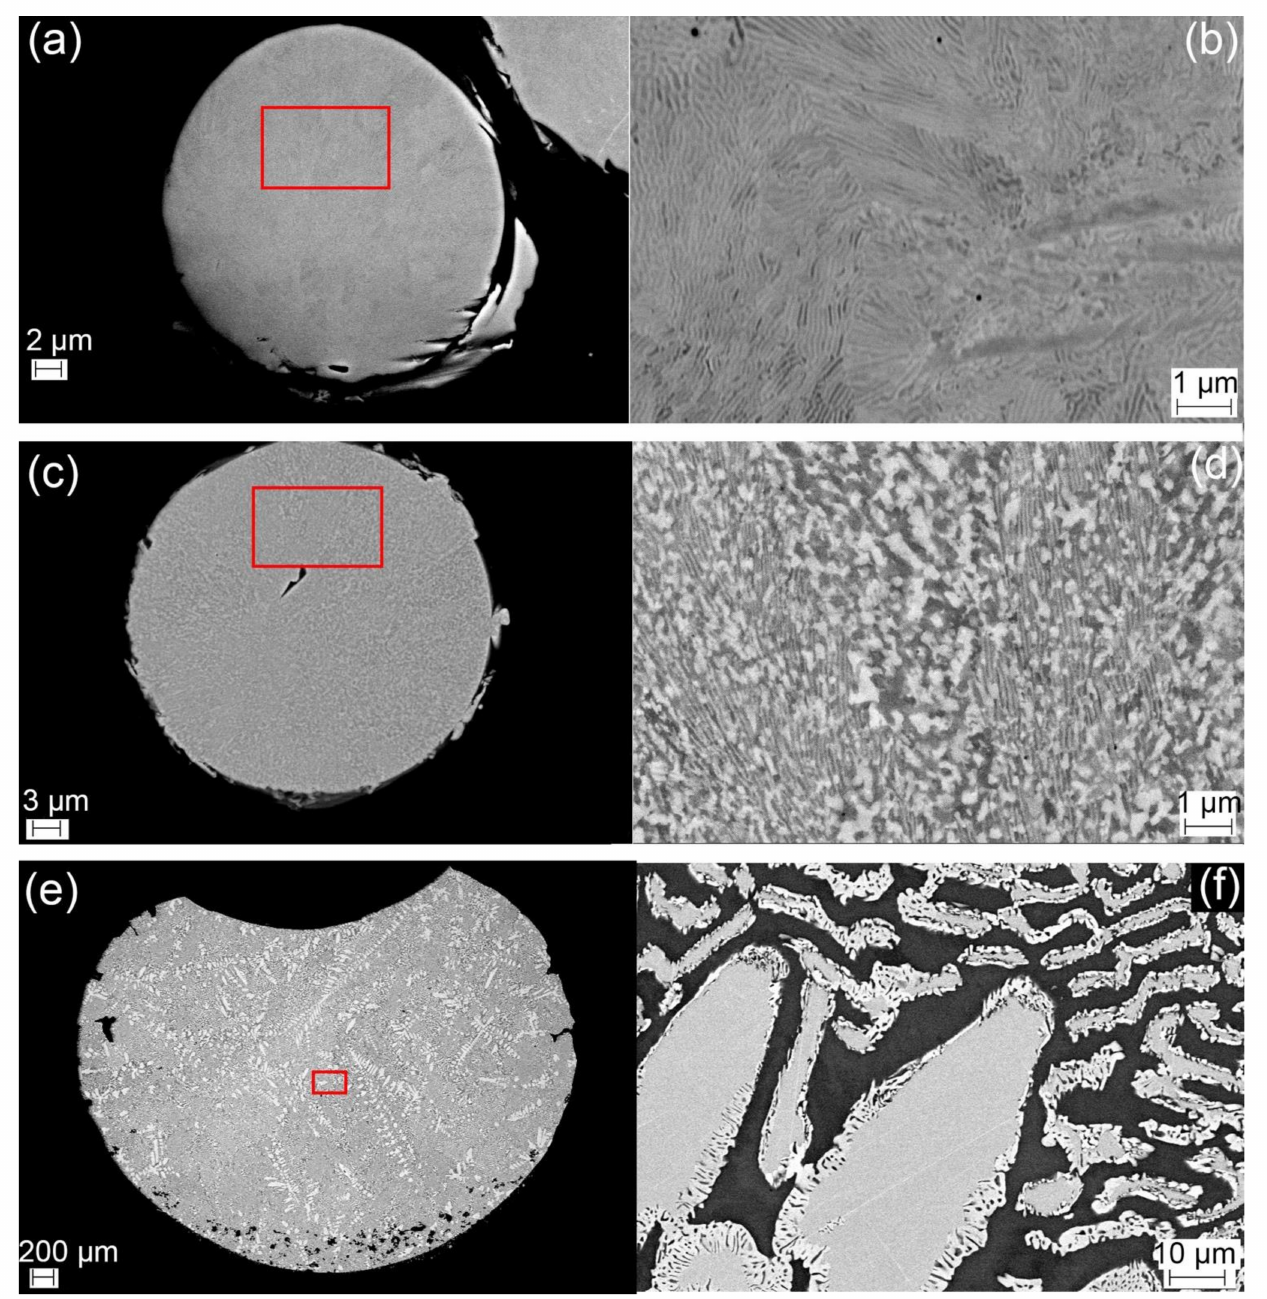
Figure 3. Backscattered electron images of ( a ) as-received powder, ( b ) a highlighted region of the as-received sample in high magnification, ( c ) powder from the interrupted DTA sample at 900 ◦ C, ( d ) a highlighted region in interrupted sample in high magnification, ( e ) the post-DTA sample in low magnification, ( f ) a highlighted area in post-DTA sample in high